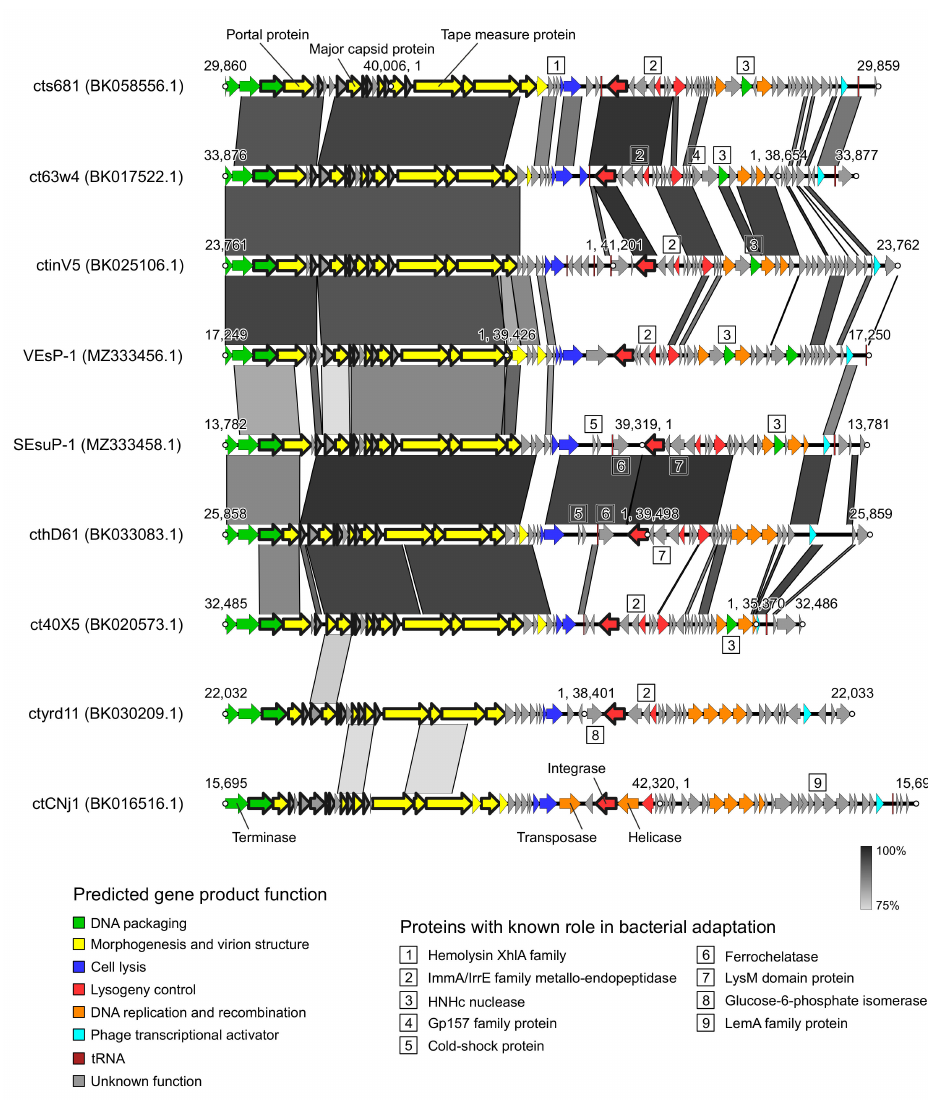
Figure 5. Genome structures in the proposed “Vespunovirus” genus. The conserved protein coding sequences are marked with a thick outline. The shades of grey show nucleotide sequence